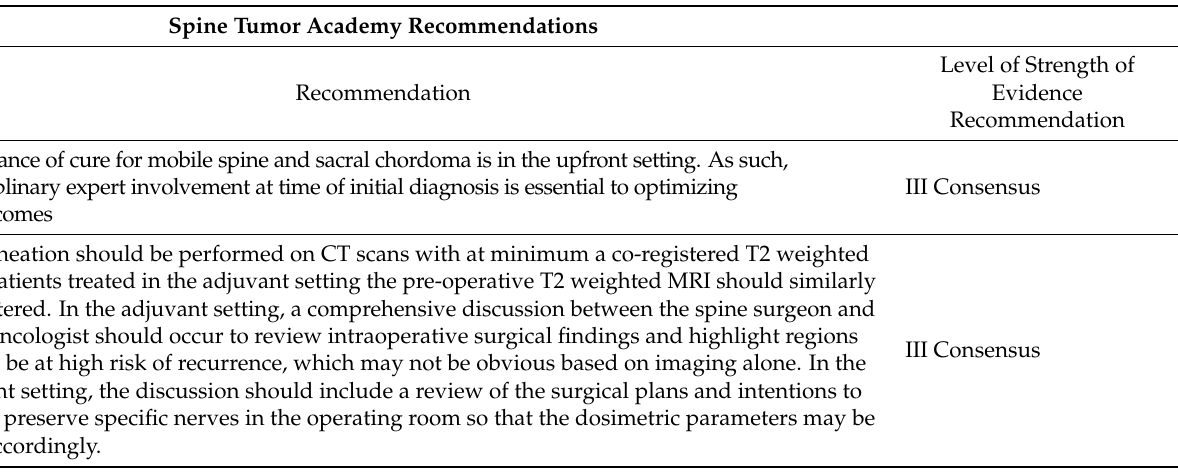
Table 7. Spine Tumor Academy recommendation